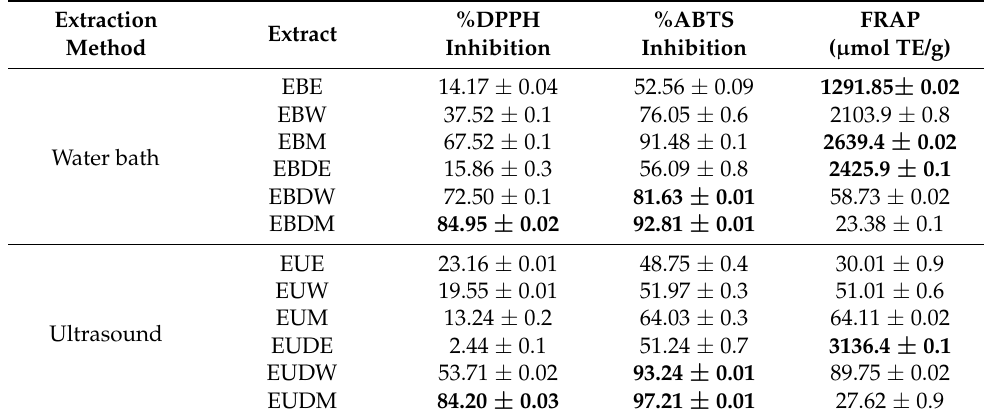
Table 1. Results of antioxidant activity of coffee husk extracts.